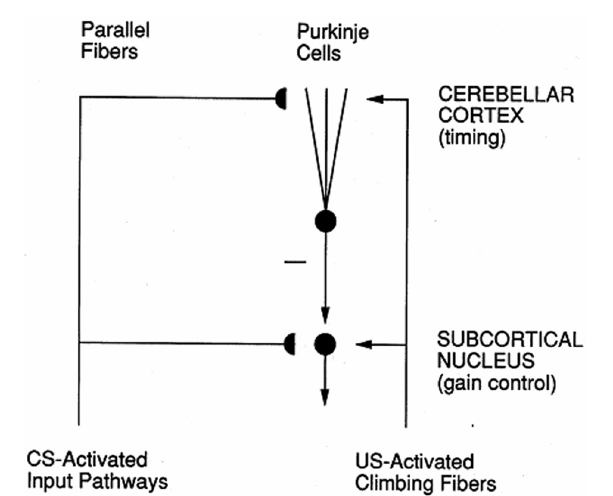
FIGURE 4 | Circuit for adaptively timed cerebellar learning. Adaptively timed Long Term Depression (LTD) at Purkinje cells depresses the level of tonic inhibitory firing of these cells to cerebellar nuclei, thereby disinhibiting cerebellar nuclear cells and allowing them to express their learned gains in an adaptively timed way. LTD occurs when adaptive weights at CS-activated parallel fiber synapses become smaller due to US-activated climbing fiber teaching signals. When this cerebellar circuit interacts with the cortico-hippocampal START or nSTART circuit that controls adaptively timed motivated attention ( Figure 3 ), attention can be maintained for an adaptively timed interval that is sufficient to read-out the adaptively timed cerebellar gains that enable an accurate movement to occur. [Reprinted with permission from Grossberg and Merrill